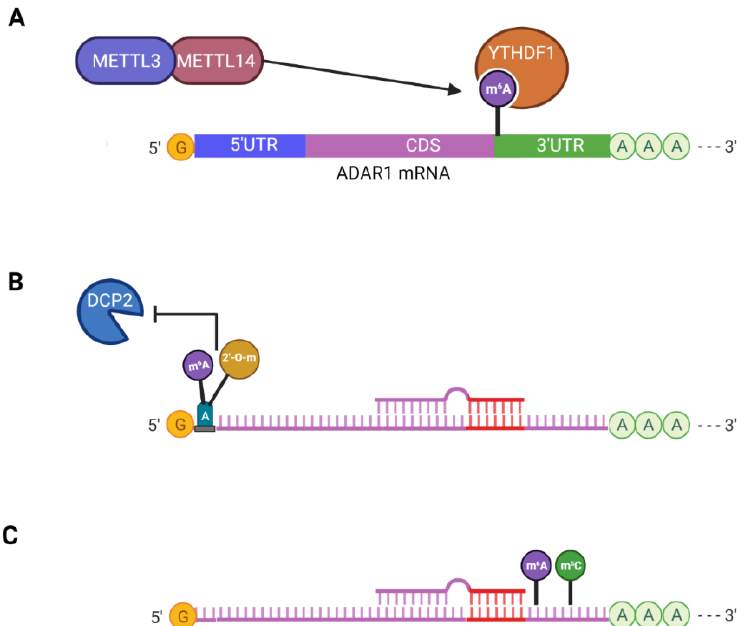
Figure 2. Crosstalk between epitranscriptomic modifications. ( A ) m 6 A regulation of ADAR1. The mRNA of ADAR1 is methylated by METTL3/METTL14 near the stop codon. This m 6 A mark recruits YTHDF1, which increases the protein translation of ADAR1. ( B ) m 6 Am modification at the first nucleotide. If the first nucleotide of an mRNA is adenine, the adenine can be methylated by m 6 A and 2′ -O-methyl (m 6 Am). m 6 Am reduces the decapping activity of DCP2, thus rendering the mRNA resistant to miRNA-mediated degradation. ( C ) Cooperative interaction between m 6 A and m 5 C. m 6 A and m 5 C can cooperatively enhance the addition of each other to the 3 (cid:48) UTR of mRNAs. Both modifications occur close to the miRNA and AGO binding site. Their role in miRNA binding is speculative. Created with BioRender.com (accessed on 17 February